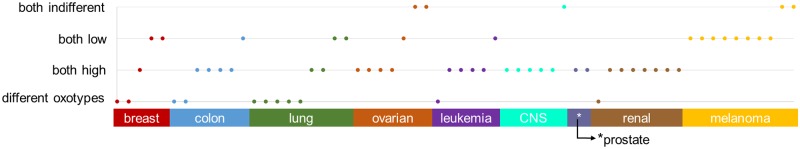
Oxotype of model pairs.Replicate models of the same cell line predominantly share the same oxotype. Only 11 model pairs have distinct oxotypes (different oxotypes). A tissue pattern becomes apparent for the melanoma cell lines. Melanoma cell lines predominantly have a low oxotype.